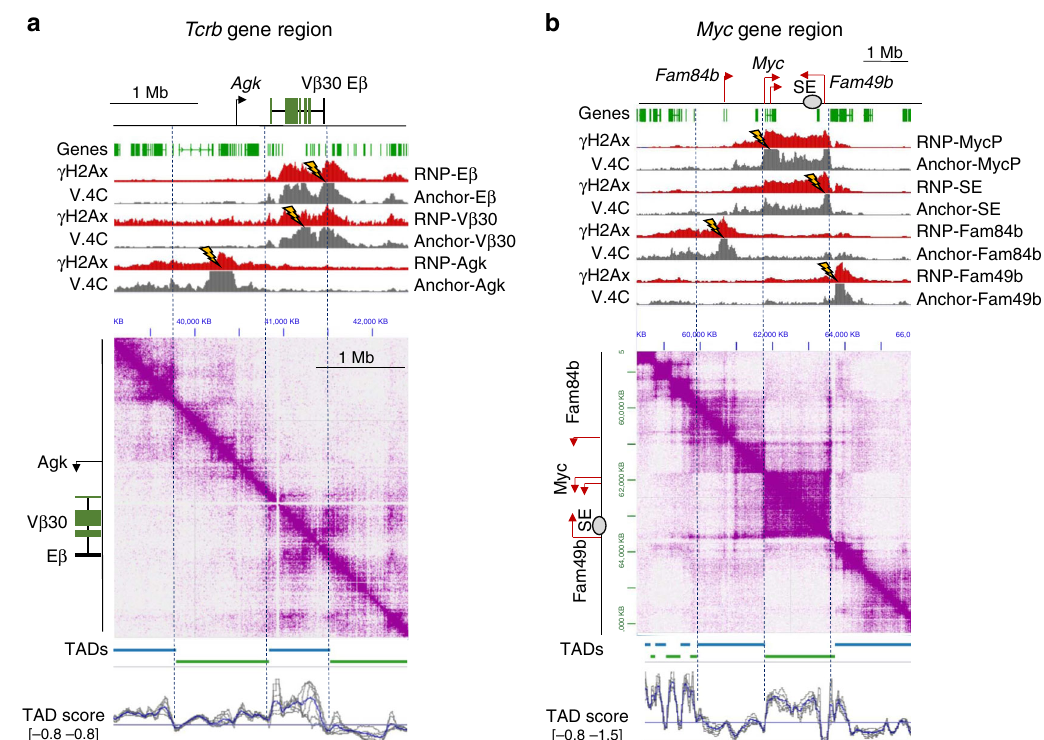
TAD score [–0.8 –0.8] Fig. 3 TADs contribute to compartmentalization of γ H2Ax signaling domains. JuiceBox browser snapshots showing paired γ H2Ax and interactome measurements across Tcrb ( a ) or Myc ( b ). Locations of genes, gene segments, and regulatory elements are shown at the top of each panel. RNP target locations and V.4C data extraction viewpoints are shown as lightning bolts. Tracks represent values for γ H2Ax CR-seq (Red, representative of two independent replicates each, scaled min to max) or V.4C (Gray, n = 2 merged independent replicates, 0 – 25 contacts). Bottom: JuiceBox Hi-C plots after coverage normalization ( n = 2, merged independent replicates each). G1-arrested Lig4 − / − v-abl cells were used for Tcrb DSBs, while cycling Rag2 − / − cells were used for targeting DSBs to Myc . Dashed lines represent selected TAD locations. The IGV tracks under the Hi-C data also show TADs, as well as their insulation scores, derived from 40 kb bins (blue lines) or 20 to 100 kb bins (gray